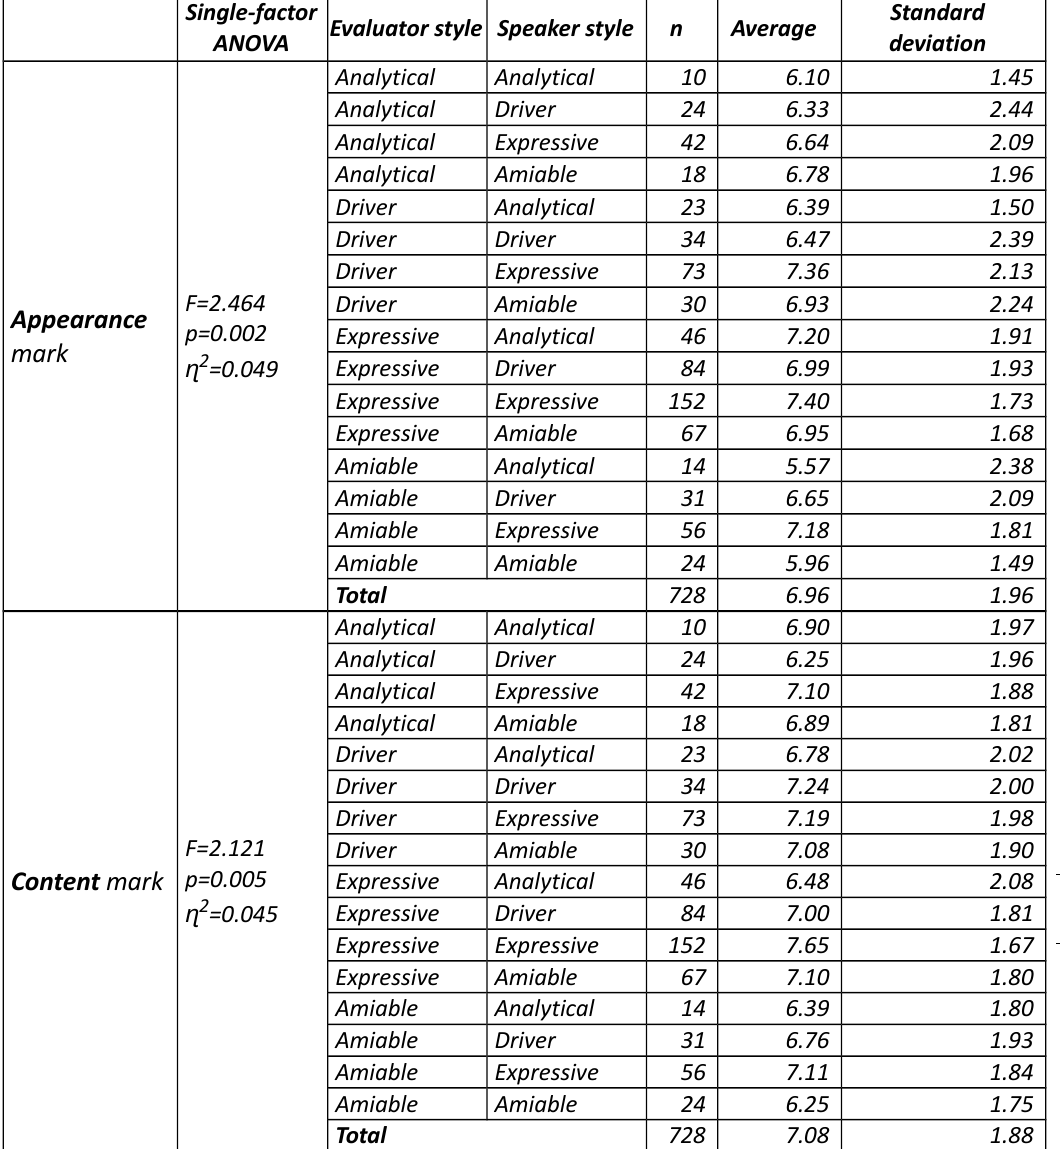
Table 2. Analysis by social style pairs. Characteristics of the average marks for each combination of social styles. There is